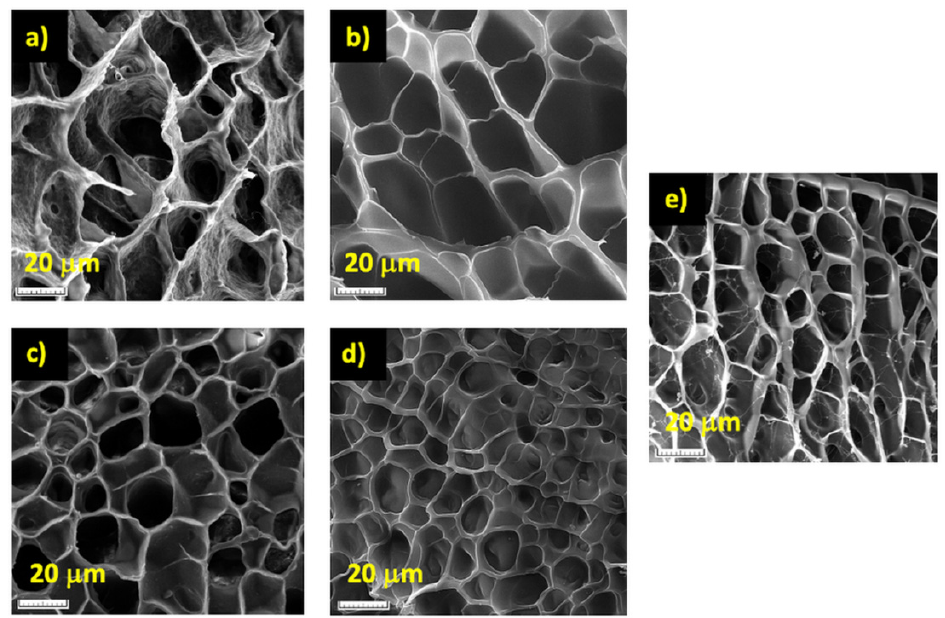
Figure 3. SEM images of lyophilized hydrogels. ( a ) HMBA 4 ; ( b ) HDVE 4 ; ( c ) HMBA 4 -XLG 10 ; ( d ) HDVE 4 -XLG 10 ; ( e ) HXLG 10 .